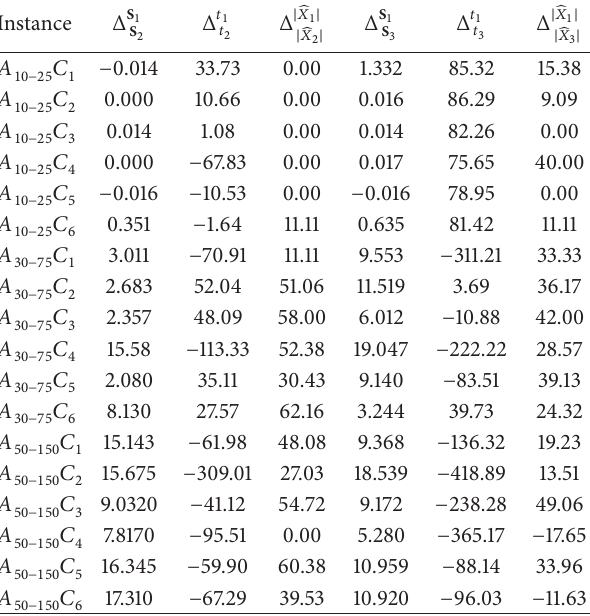
Table 3: Results obtained by well-known MOEA algorithms NSGA- II and PAES for instances of class 𝐴 .